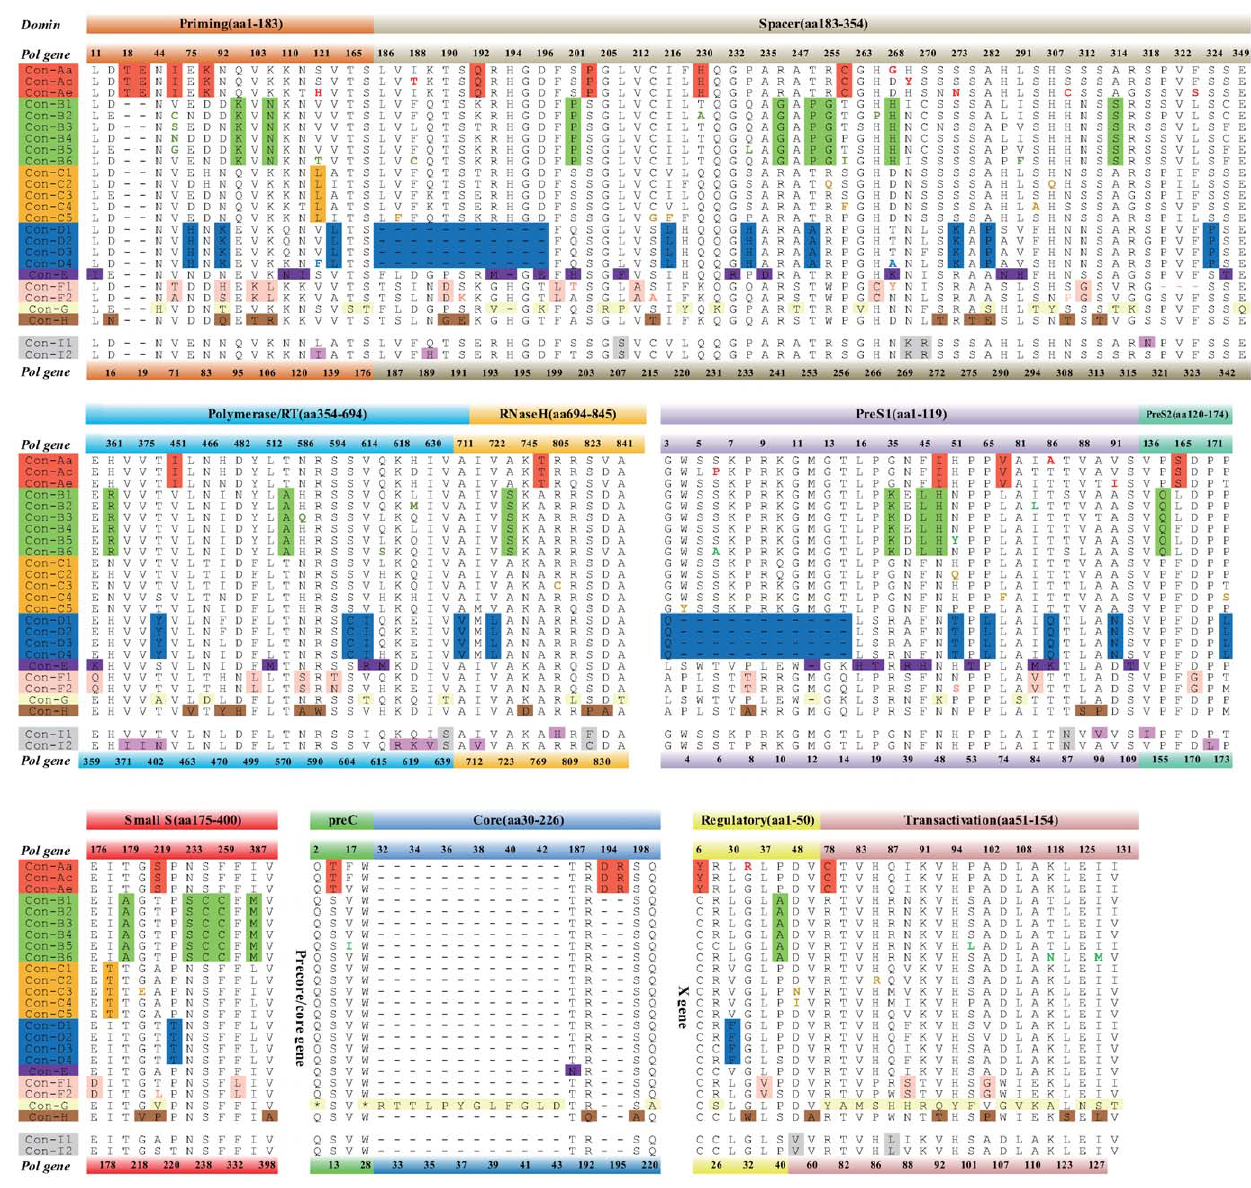
Figure 5. Consensus amino acid sequences of 4 gene products of HBV ( P , S , X and Pre-core/core ) were arrayed according to genotypes and subtypes, with identical columns excluded. Consensus sequences were derived from the 322 reference sequences. For page view limited, unique sites in subtype were also omitted and the sequence number of amino acids was indicated alternately on the top and bottom of the aligned matrix. Genotype-specific amino acids were highlighted with different colors and subtype-specific amino acids were only displayed in corresponding colored letters.